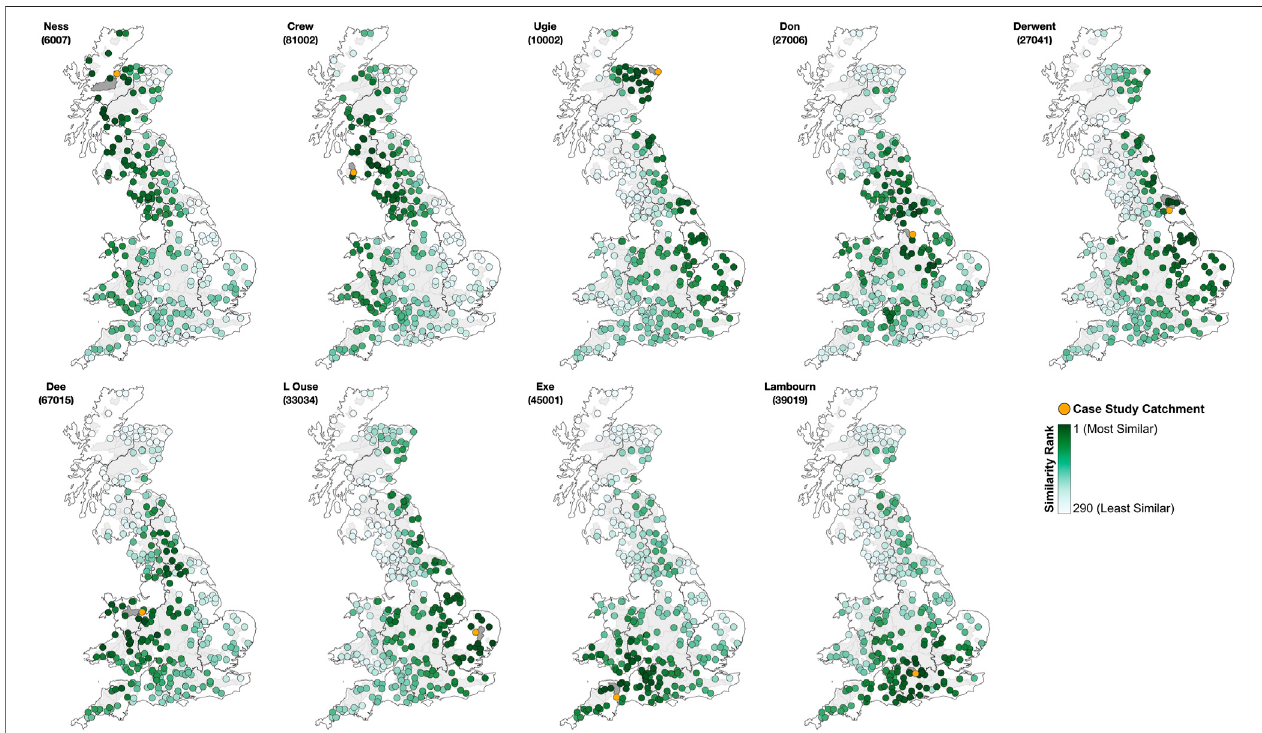
FIGURE 5 | Similarity analysis results based on the NAO/EA SPI-1 correlation time series mapped in Figures 2 , 3 . The case study catchment is highlighted in yellow. Catchments with lower values indicate those which have greater similarity in their NAO/EA monthly correlations to those of the case study catchment. Catchments with higher values indicate those which have NAO/EA correlations which are less